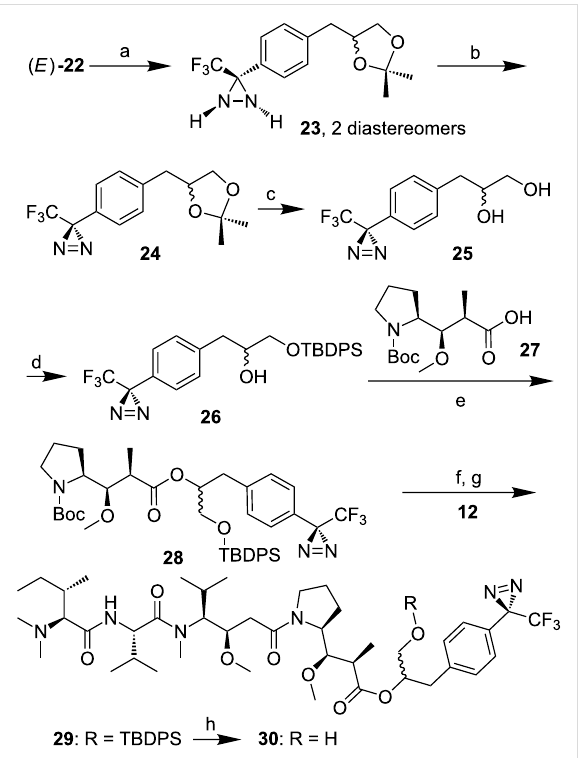
Scheme 4: Synthesis of photo malevamide D 30 . a) NH 3 (l), t -BuOMe, − 40 °C, 2 h, rt, 16 h, quant. b) I 2 (1.2 equiv), NEt 3 (2.2 equiv), Et 2 O,